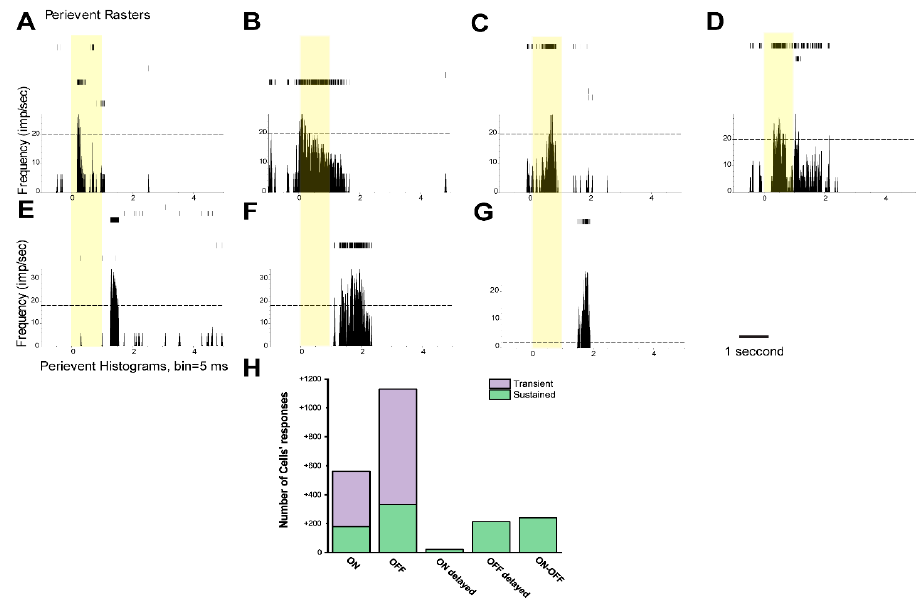
Figure 1. Major types of cells’ responses were identified based on their response profiles to light in the mouse retina. Raster plots and peristimulus time histograms (PSTHs) of cells’ responses were recorded with a multi-electrode array (MEA): ( A ) ON-transient retinal ganglion cell (RGC) to a 1-s full-field light stimulus with its Raster plots (upper part) and PSTH (lower part), ( B ) ON-sustained RGC, ( C ) ON-delayed RGC, ( D ) ON–OFF RGC, ( E,F ) OFF-transient RGC and OFF-sustained RGC and ( G ) OFF-delayed RGC or displaced amacrine cell (AC). A 525-nm full-field (light intensity 1311 Rh* / rod / sec) 1-s light stimulus was applied. ( H ) Summary of numbers inside histograms represent recorded